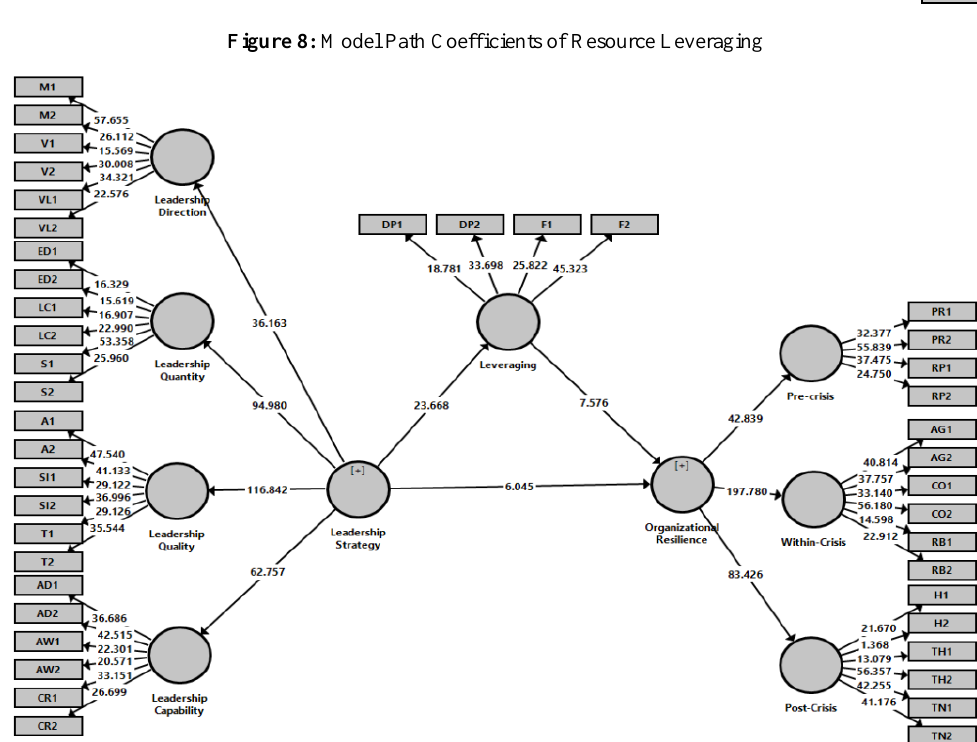
Figure 9: Mode t-Statistics of Resource